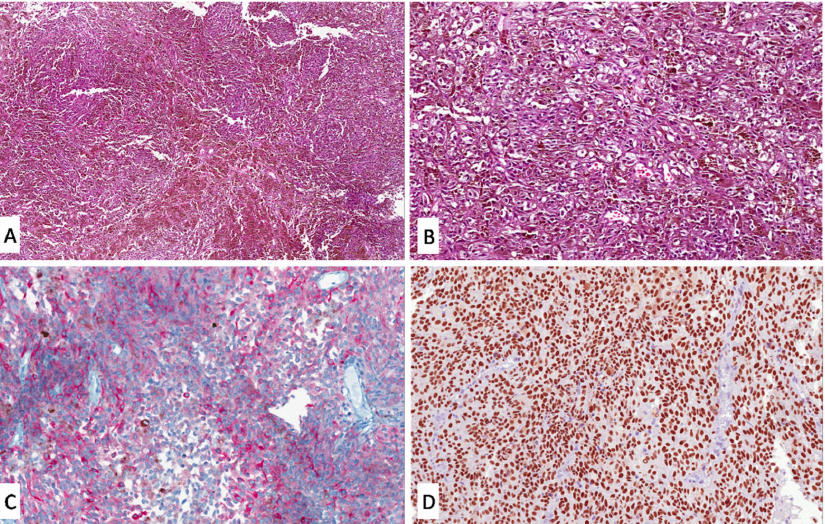
Figure 2. ( A ) Low magnification showing a uniformly hypercellular and heavily pigmented tumor (H&E; original magnification 50 × ); ( B ) most of the lesion is composed of pigmented epithelioid cells with large eosinophilic cytoplasm and hyperchromatic nuclei (H&E; original magnification 200 × ); ( C , D ) tumor cells exhibit heterogeneous, strong and diffuse immunoreactivity for Melan-A ( C ) and SOX10 ( D ), respectively (immunoperoxidase; original magnifications 200 ×